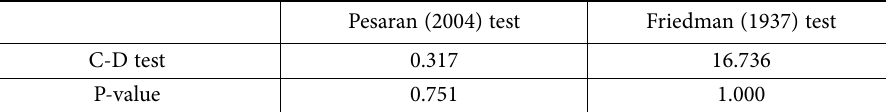
Table 3. Cross-sectional dependence